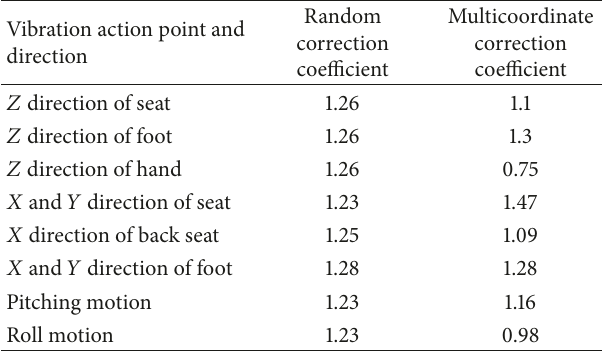
Table 3: The optimized